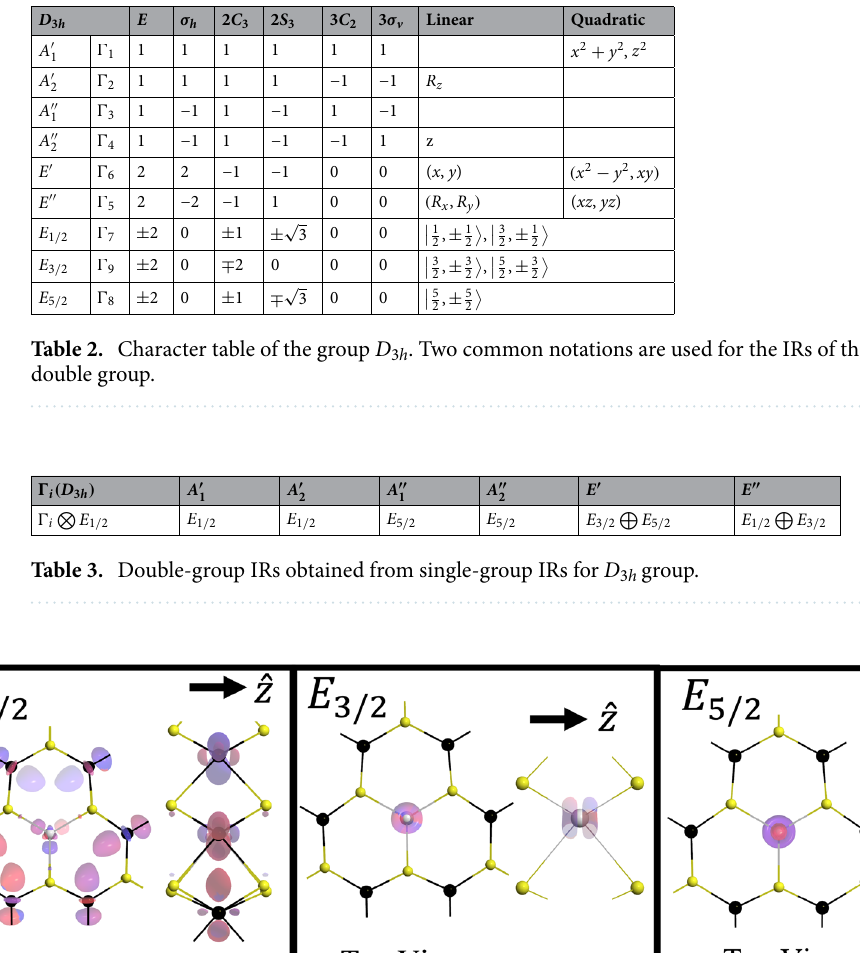
Figure 4. Examples of the Bloch states for the Ho W impurity in 8